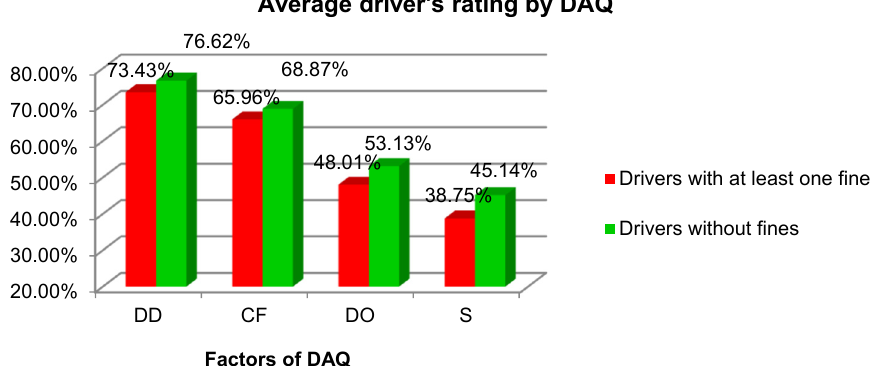
Figure 5. Average rating of Driver Attitude Questionnaire (DAQ) factors according to fines. Source: processed by authors.